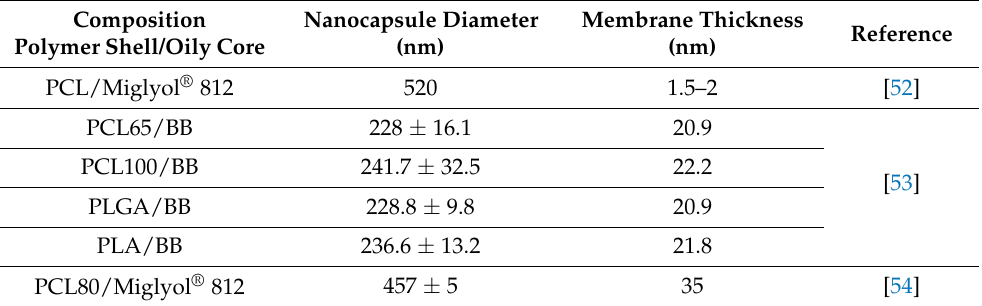
Table 1. Examples of nanocapsule diameters with oily core and membrane thicknesses.